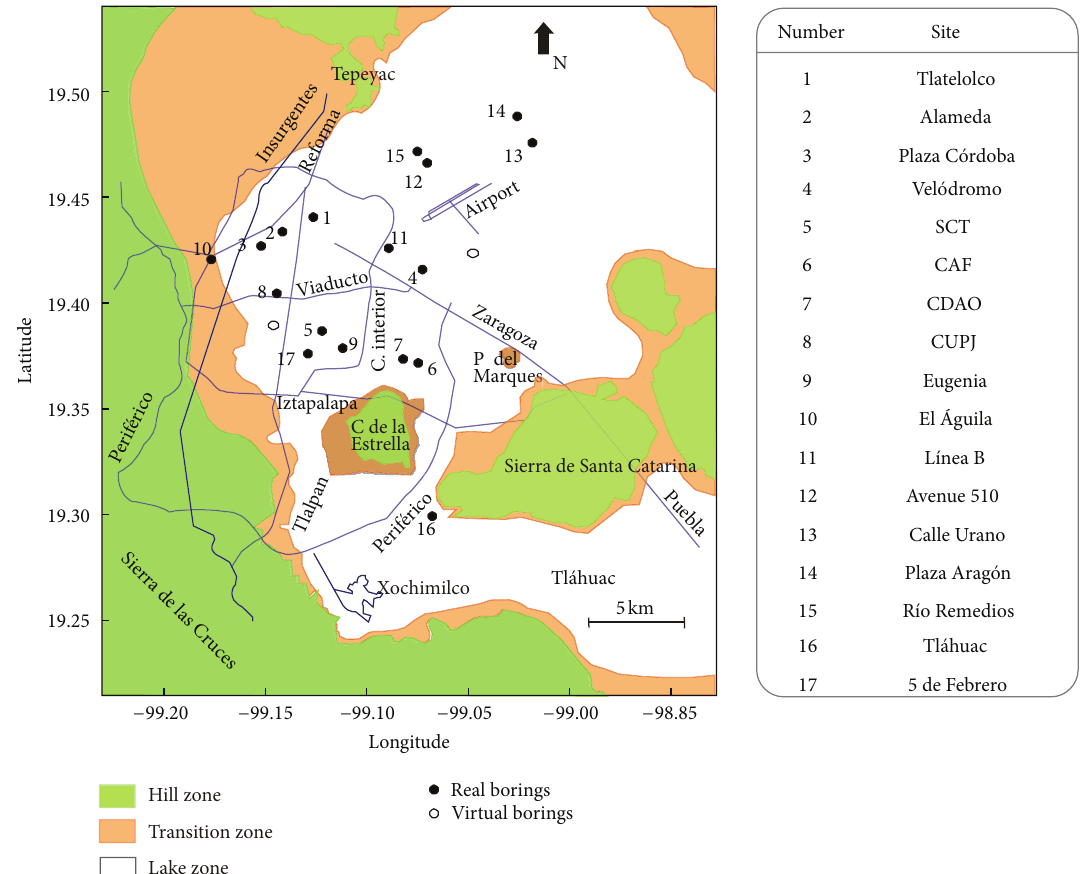
Figure 2: Geotechnical zones and exploration sites, Mexico